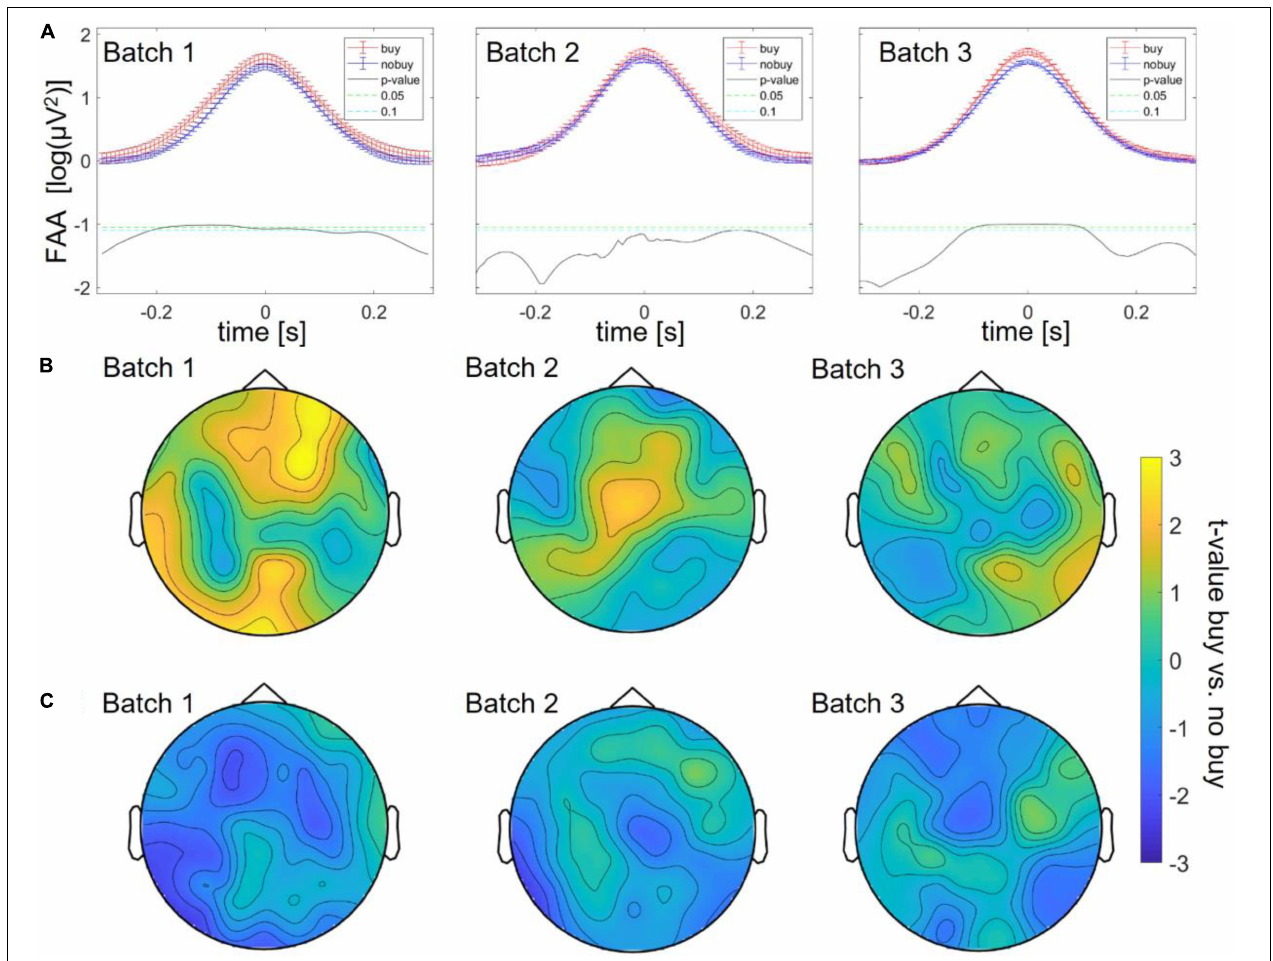
FIGURE 2 | Differences between buying and no-buying trials in Study 1 divided into batches, (A) increased frontal alpha at frontal alpha asymmetry (FAA) peaks, (B) increased frontal theta at theta peaks, and (C) decreased occipital alpha at FAA